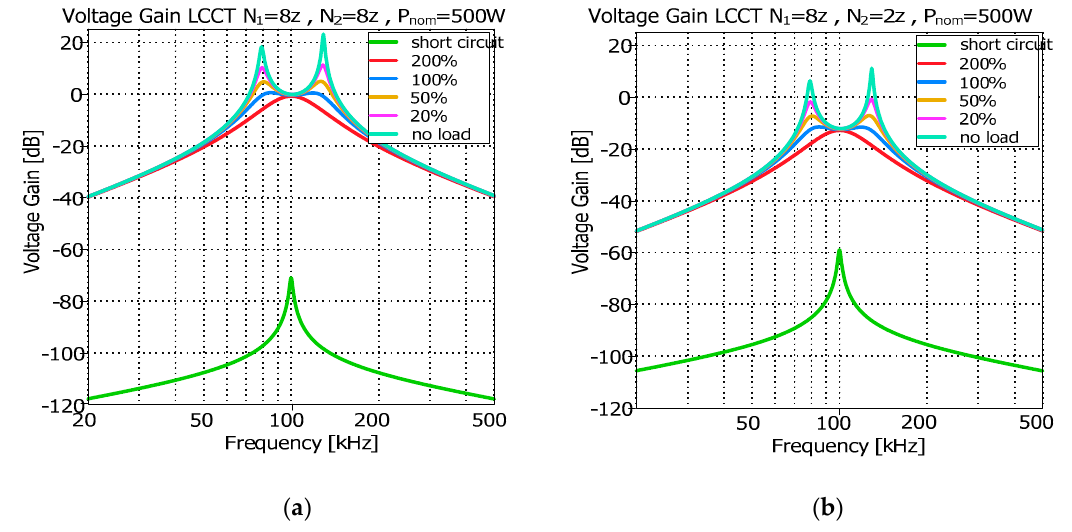
Figure 2. Voltage gain characteristic with operating regions .